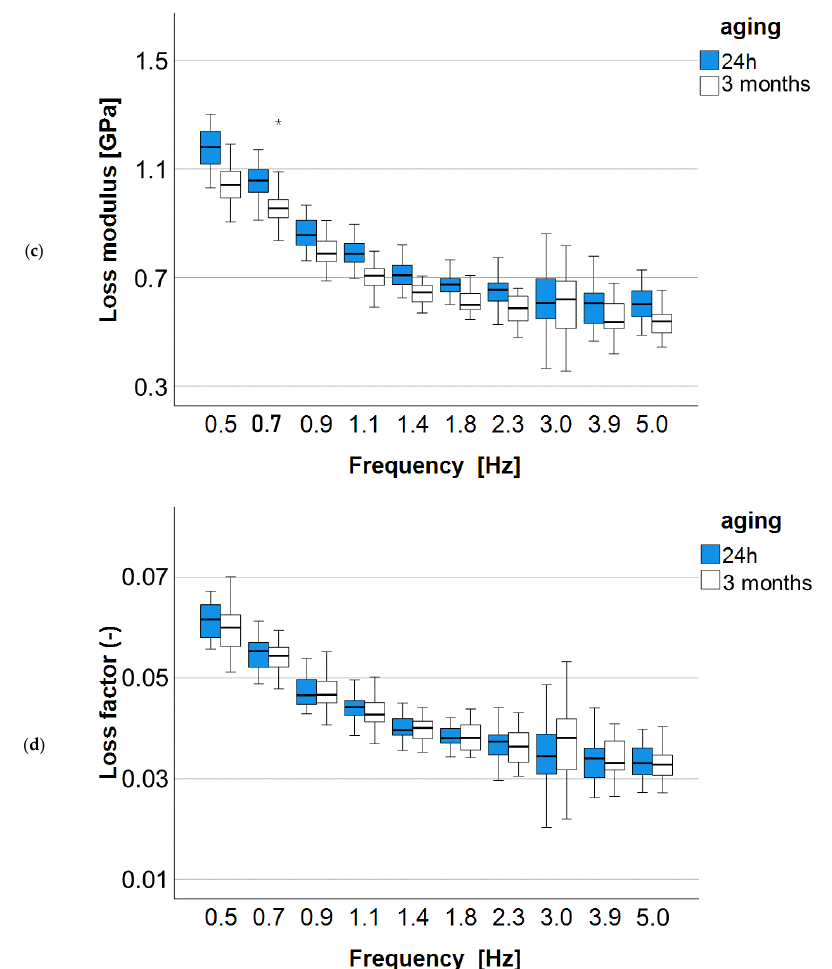
Figure 14. ( a ) Dynamic mechanical analysis: indentation hardness (H IT ) as a function of aging and frequency exemplified for the material FSD (=Filtek Supreme XTE Dentin). ( b ) Storage modulus as a function of aging and frequency exemplified for the material FSD (=Filtek Supreme XTE Dentin). ( c ) Loss modulus as a function of aging and frequency exemplified for the material FSD (=Filtek Supreme XTE Dentin). ( d ) Loss factor as a function of aging and frequency exemplified for the material FSD (=Filtek Supreme XTE Dentin) (asterisks indicate outliers). Table 4 summarizes the simple contrast estimation (comparison of the aged versus unaged groups) for each parameter. The a priori contrasts show statistically significantly higher H IT results in the aged groups compared to unaged groups for BEG (M Diff = 25.6)